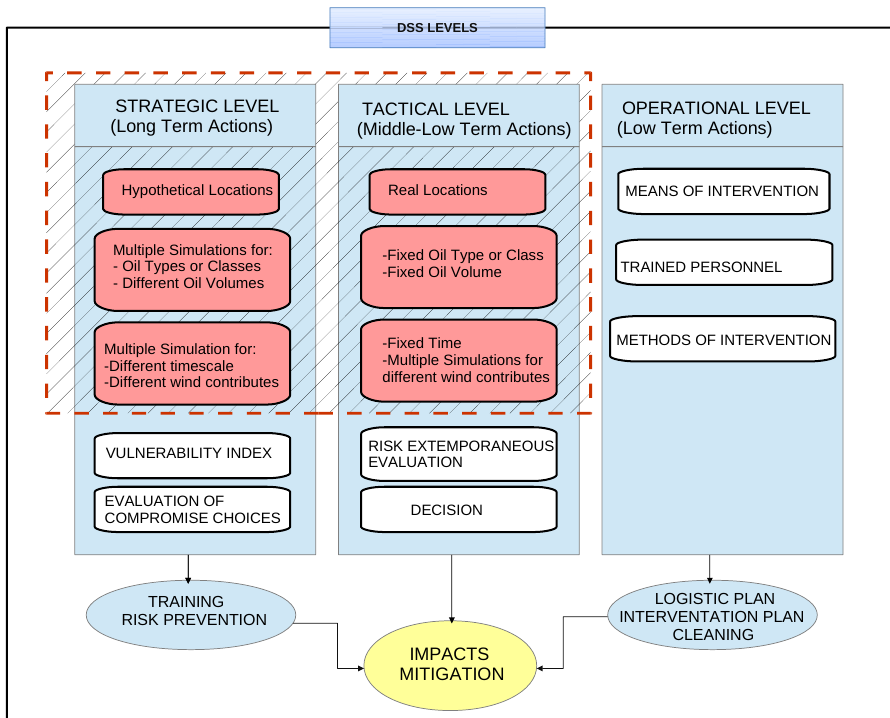
Figure 7. The GUI meets some points of the strategic and tactical levels of a Decision Support System (DSS) (red boxes in the dashed box). The active functions of the GUI (red boxes) allow to strongly minimize the response time of a decision making process in case of an oil spill